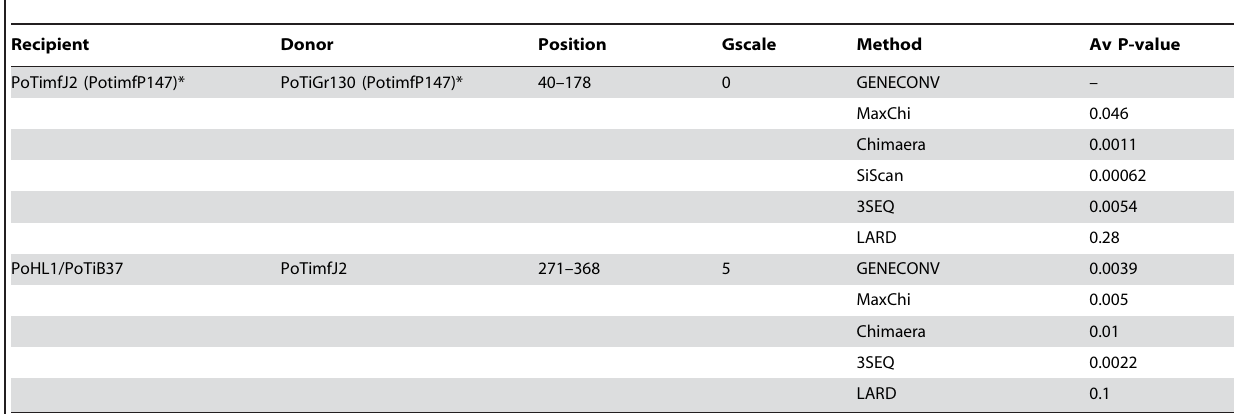
Table 4. Recombination at ospC of B. lusitaniae